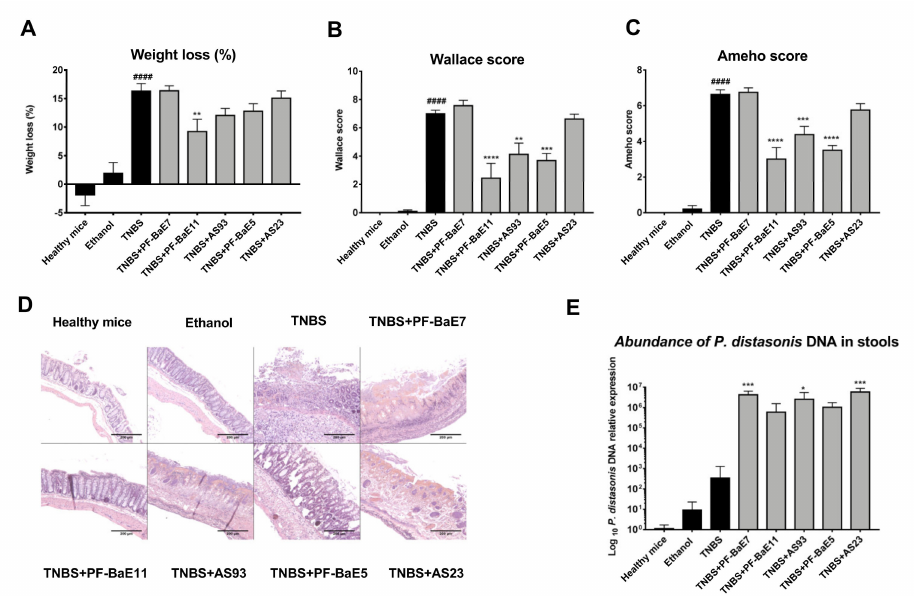
Figure 4. Ability of Parabacteroides distasonis strains to counteract the acute TNBS-induced colitis. ( A ) Body weight loss (as a percentage of the initial weight). ( B ) Macroscopic evaluation of colonic inflammation (Wallace score). Percentages of protection are indicated above each bar. ( C ) Histologic evaluation of colonic inflammation (Ameho score). ( D ) Representative histological sections (stained by H&E, 100 × magnification) of mice treated with TNBS (TNBS) or not (healthy mice, ethanol-control mice) and orally treated with the selected strains. Data represent means of each group ( n = 9 mice per group) ± SEM. # and * refer to the comparisons of TNBS versus healthy mice or bacteria-treated group versus TNBS control group, respectively; ** p < 0.01, *** p < 0.001, #### or **** p < 0.0001. ( E ) Abundance of P. distasonis specific DNA in the stools collected two days after colitis induction and evaluated by qPCR. Results are expressed as relative expression compared with values obtained from healthy mice. Data represent means of each group ( n = 9 mice per group) ± SEM. * refer to the comparisons of each group versus healthy mice; * p < 0.05, *** p <